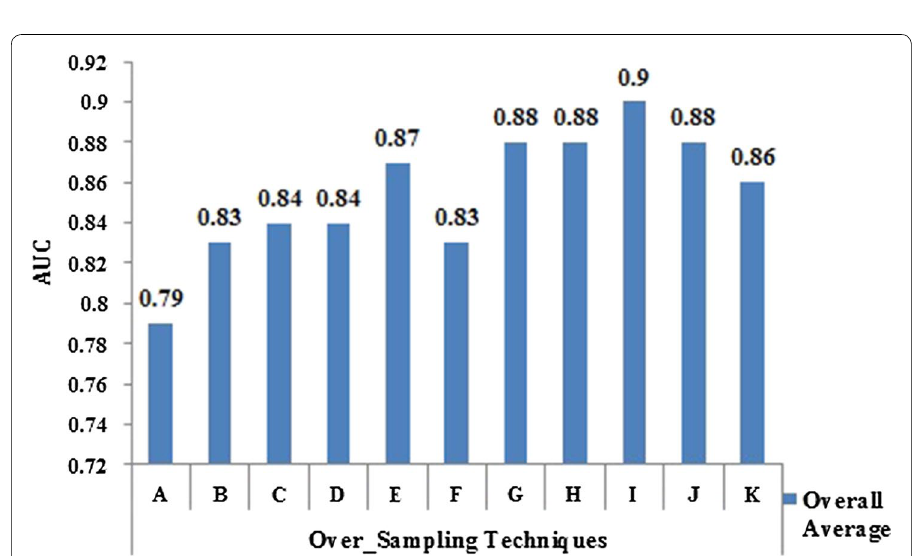
Fig. 7 Average AUC values for multi-class structured data set